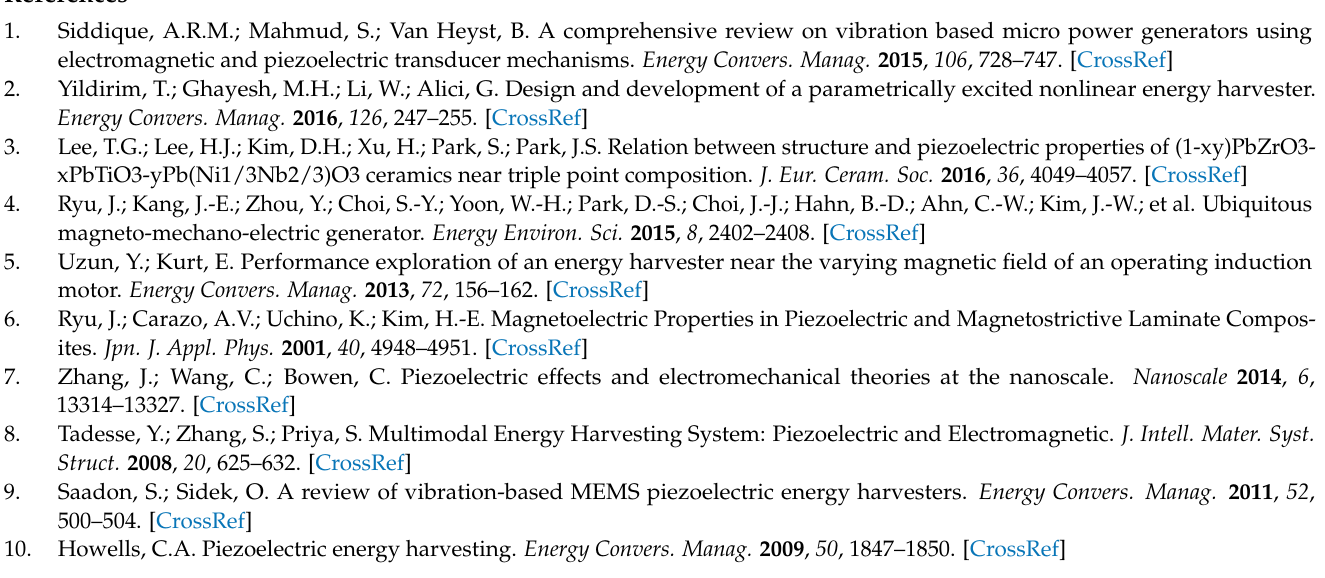
Figure S2: Signal microcontroller of self-powered wireless temperature monitoring system, Figure S3: Surface FE-SEM images of the BCTZC 0.3 ceramics sintered at different temperatures, Figure S4: Energy dispersive spectra (EDS) mapping analysis of the 1500 ◦ C BCTZC 0.3 composites, Figure S5: surface images of the BCTZC 0.3 sample sintered at 1500 ◦ C. Self-powered wireless temperature monitoring system and More material information can be found in the Supplementary